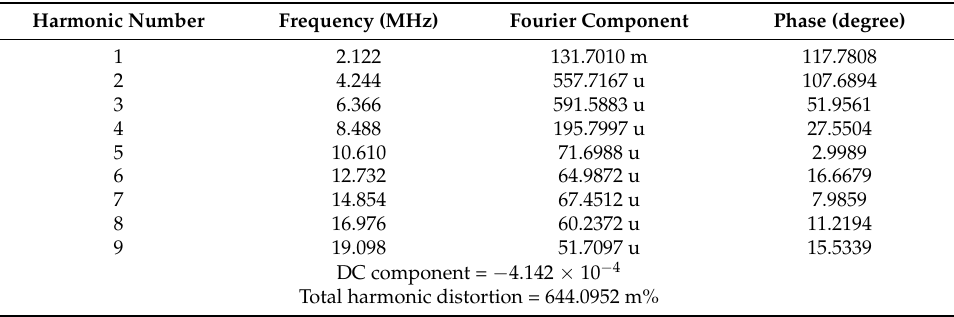
Table 5. Total harmonic distortion analysis of V o 2 in Figure 3.